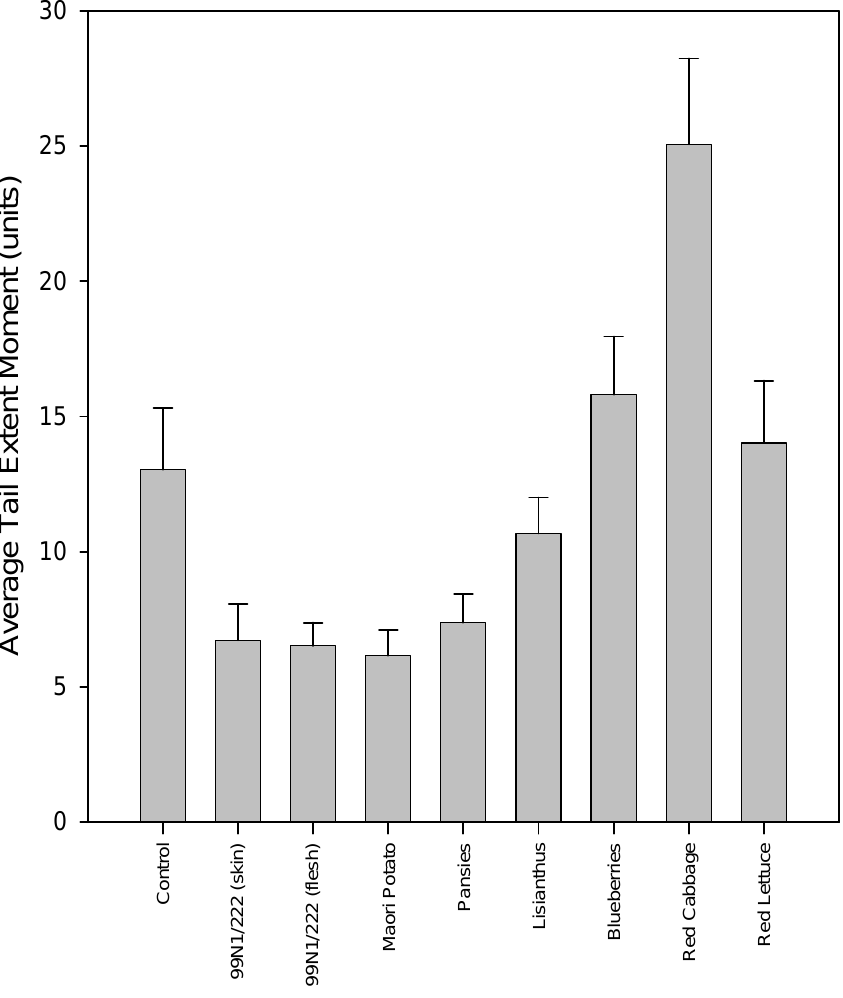
Figure 8 . Bar graph showing the average tail extent moments and standard errors from 100 comets incubated in different anthocyanic plant extracts in the 20  L H treatment group.